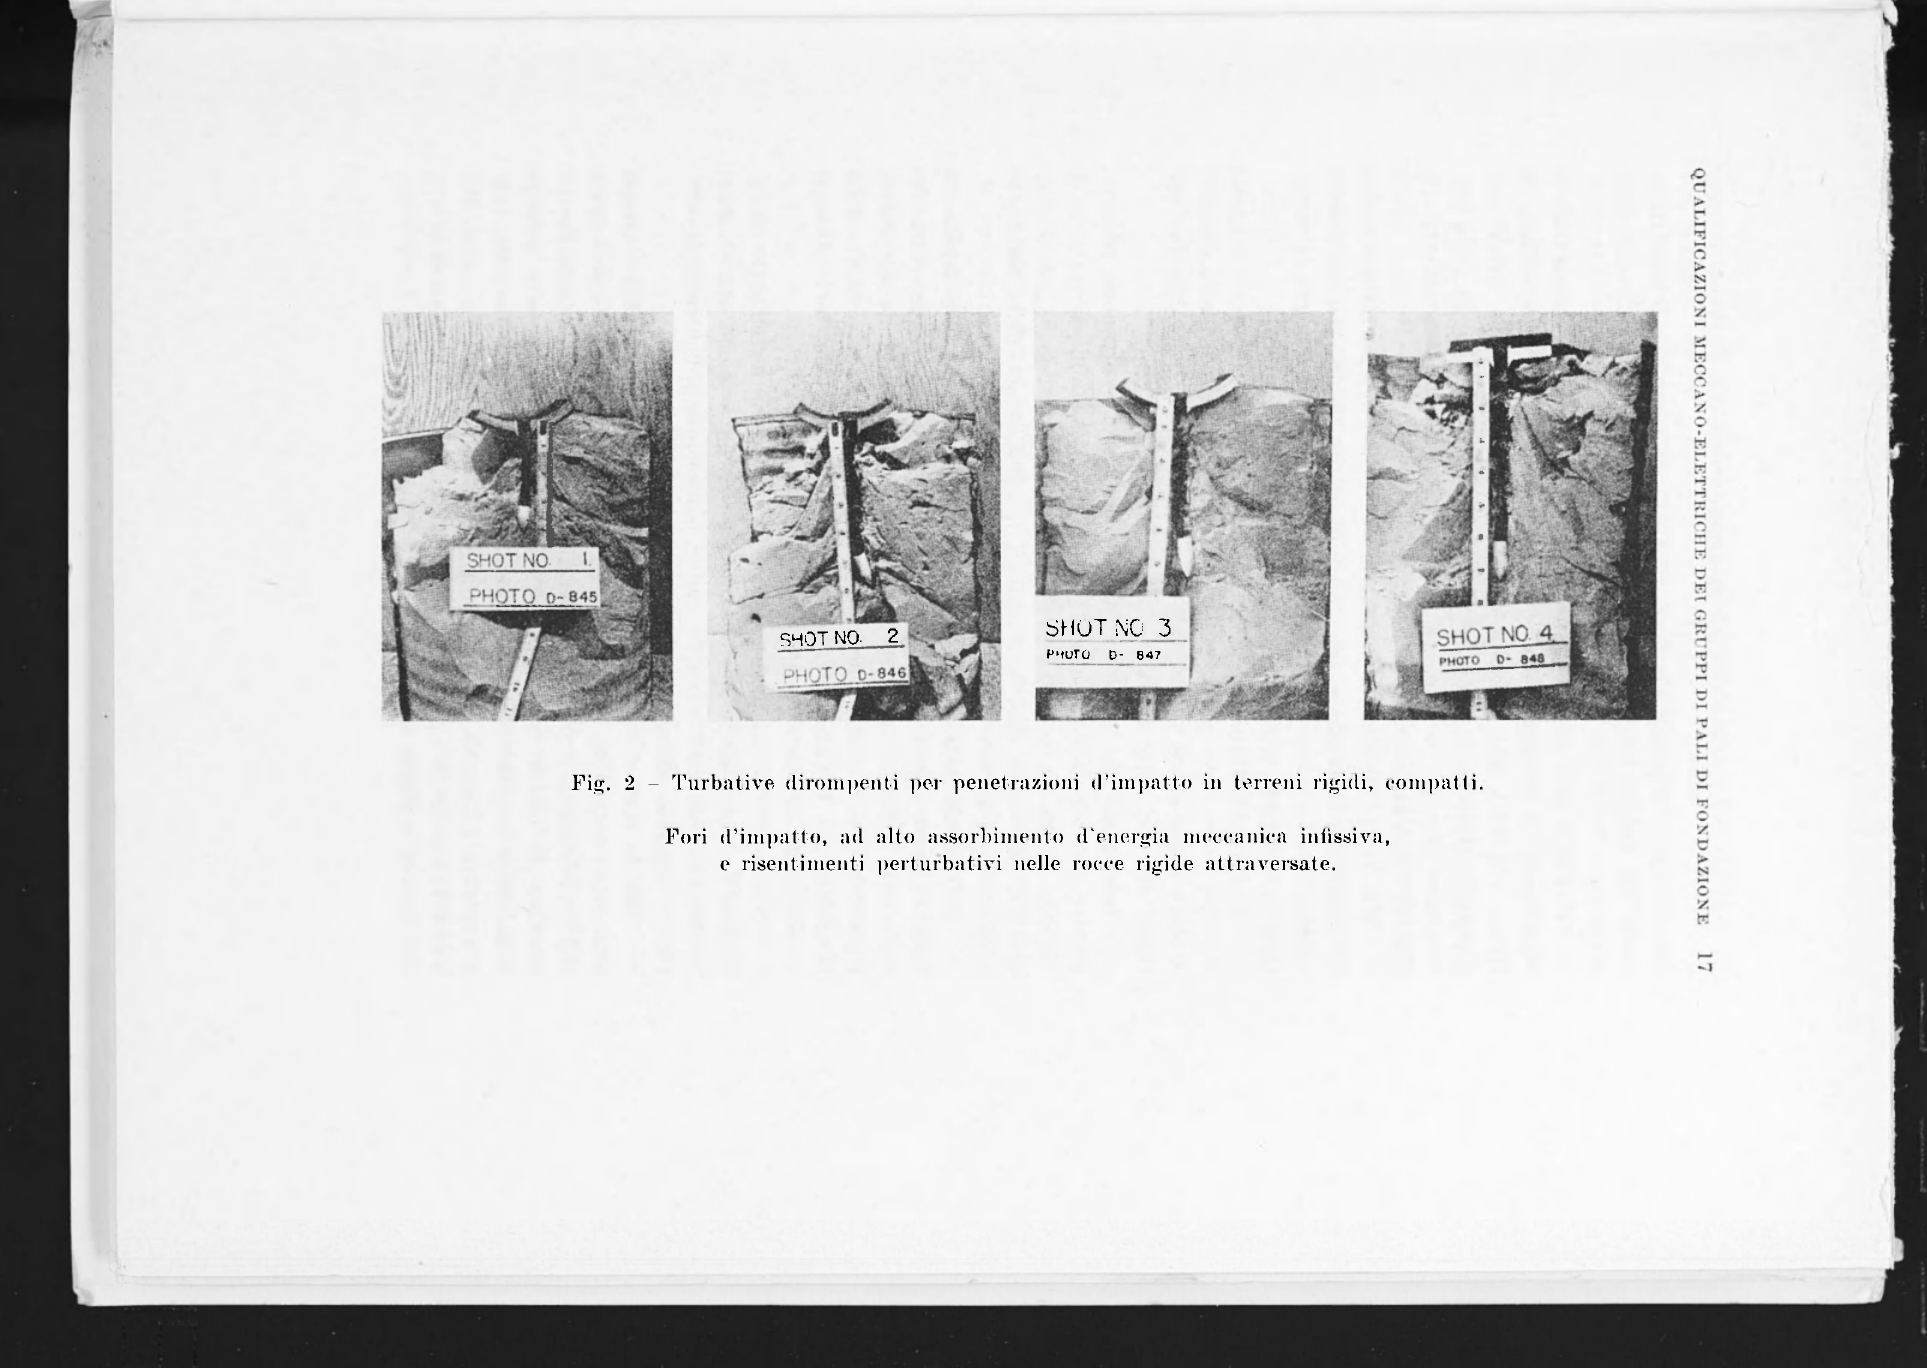
Fig. 2 - Turbative dirompenti per penetrazioni d'impatto in terreni rigidi, compatti. Fori d'impatto, ad alto assorbimento d'energia meccanica inflssiva, e risentimenti perturbativi nelle rocce rigide